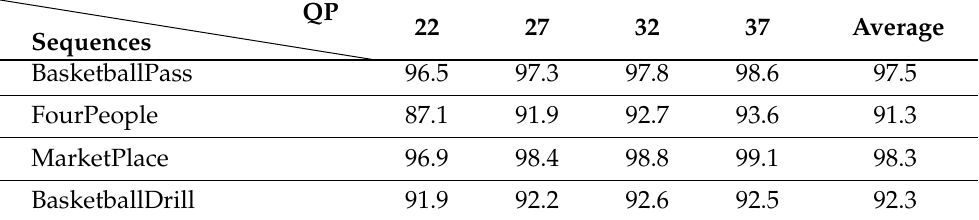
Table 6. The probability that the MVD of a CU is 0 (unit: %).